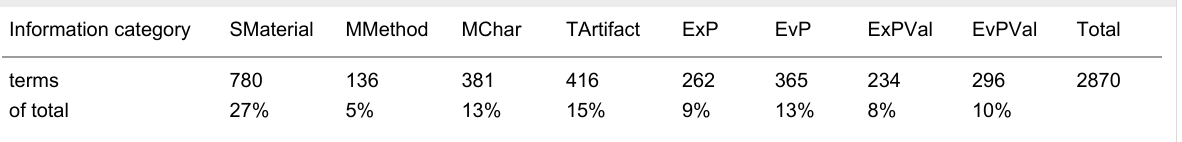
Table 1: Number of categorized terms in NaDev corpus.